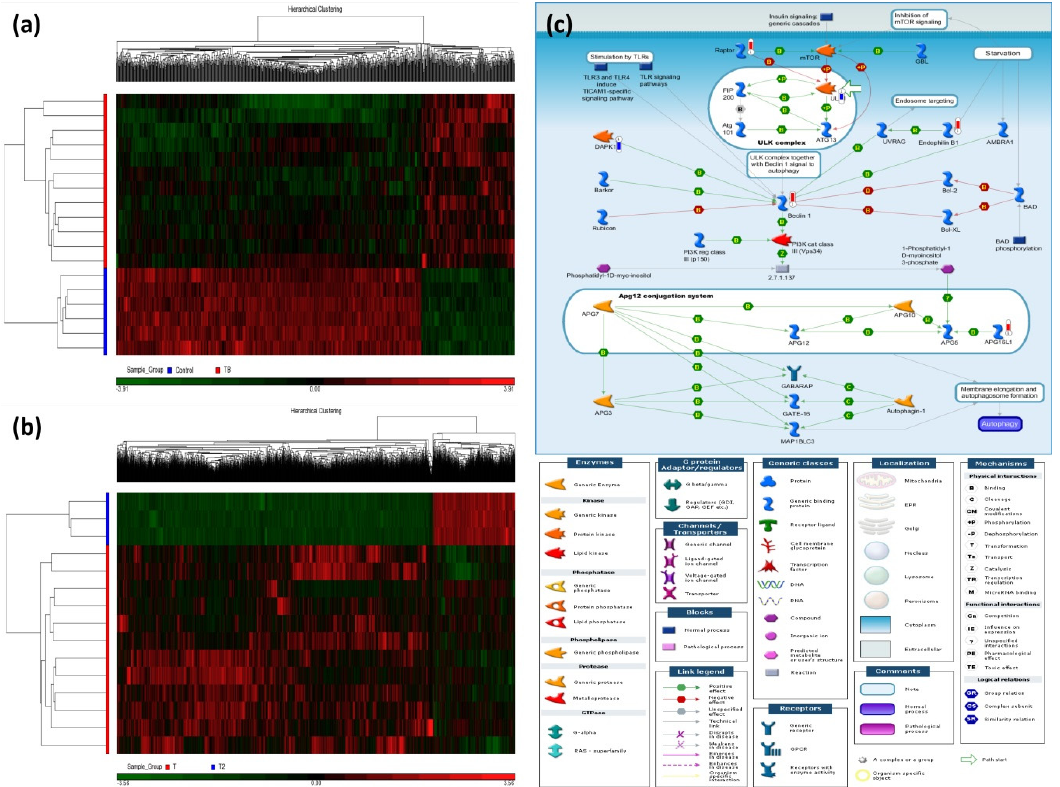
Figure 1. Heatmaps of the differentially methylated loci (DML) for the two comparisons and the most enriched pathway in the discovery cohort. Hierarchical clustering of DML in 21 samples classified into two comparisons: ( a ) Active TB patients versus healthy subjects (HS) and ( b ) TB patients after 6-month anti-TB treatment versus before treatment. ( c ) Autophagy-related gene signaling pathway enriched in active TB patients of the discovery cohort. In comparison between TB patients and healthy subjects, the significantly hypermethylated genes were highlighted with a red-colored barometric bar, while hypomethylated genes in a blue-colored bar. The changes represent the differences between the median M-values of HS and active TB patients. For example, the median M-value for HS and TB patients is 0.027 and 0.041, respectively, for BECN1 (Beclin 1), indicating a higher methylation level in active TB.